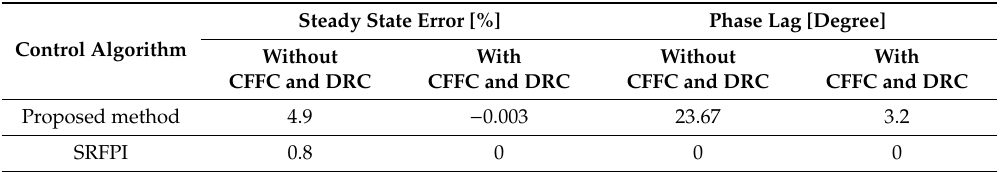
Table 3. Simulation results of GCI system phase current without and with the CFFC and disturbance rejection control (DRC).